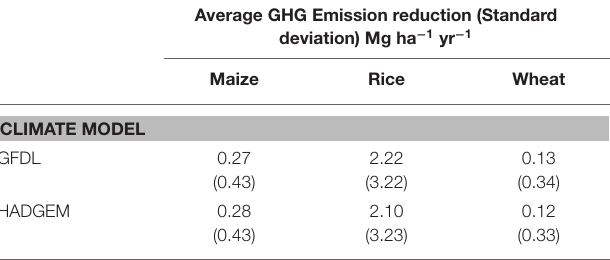
TABLE 3 | Average yearly emission reduction by